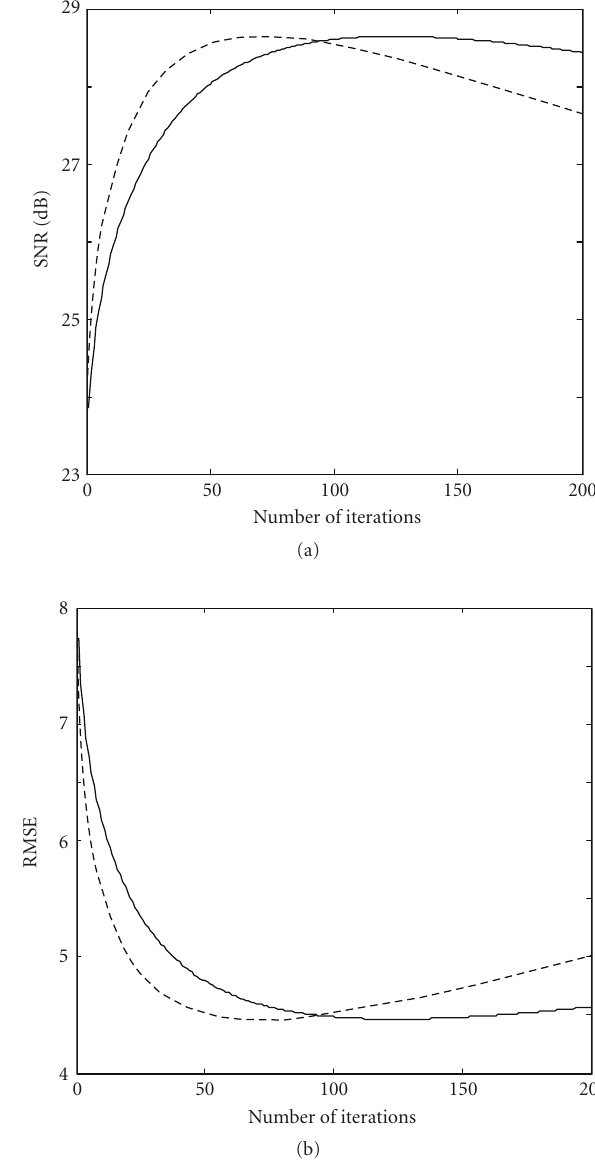
Figure 6: “Anuska” image (a) SNR of the MAPE (solid line) and AAMAPE (dotted line). (b) RMSE of the MAPE (solid line) and AAMAPE (dotted